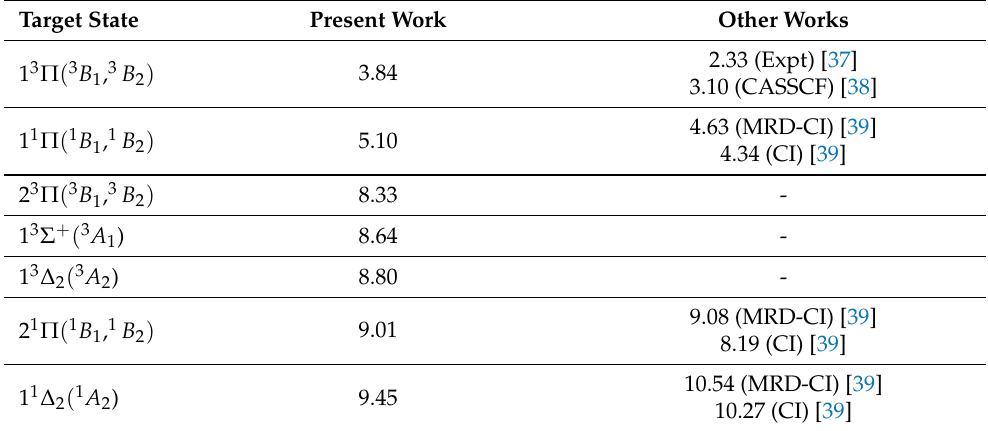
Table 2. Vertical Excitation Energies (in eV) of the excited states for the target states in C ∞ v and C 2 v symmetries.